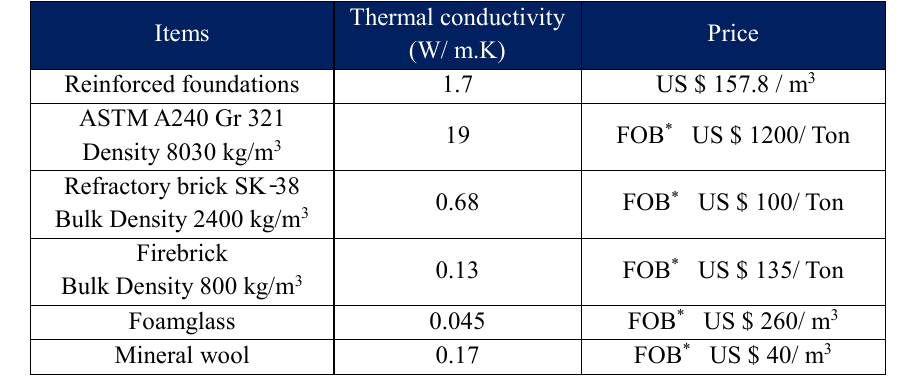
Price for hot tank row